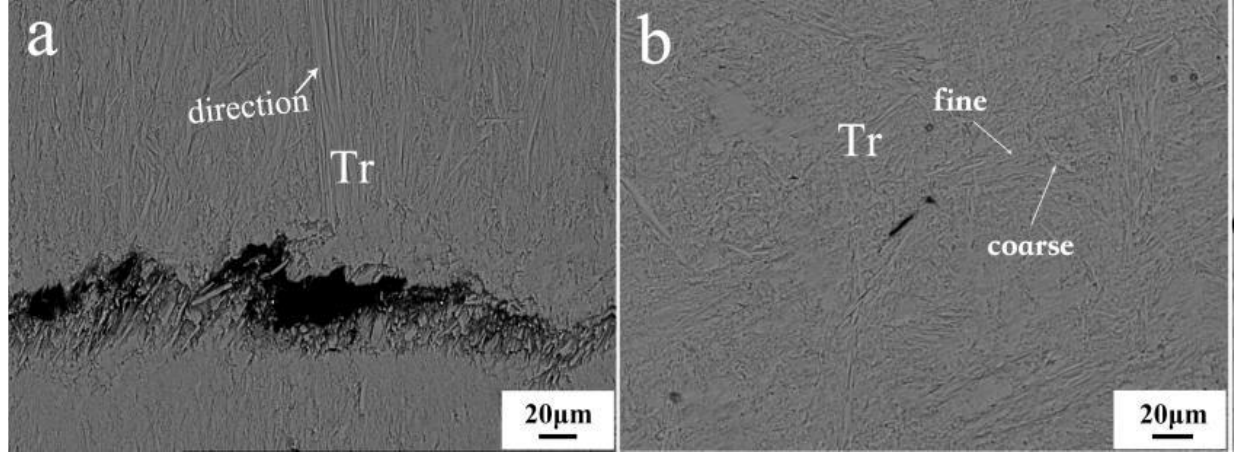
Figure 4. Back-scattered electron (BSE) images of tremolite in the samples. ( a ) Tremolite above the black hole was arranged in a fibrous direction, and had a small particle size and a fine structure. ( b ) Tremolite granules in the phenomenon of coarse-to-fine granular metasomatism. Tr: tremolite.